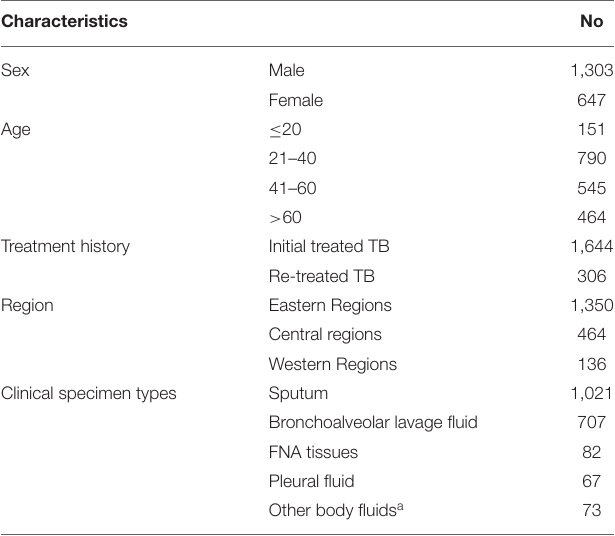
Frontiers in Cellular and Infection Microbiology |